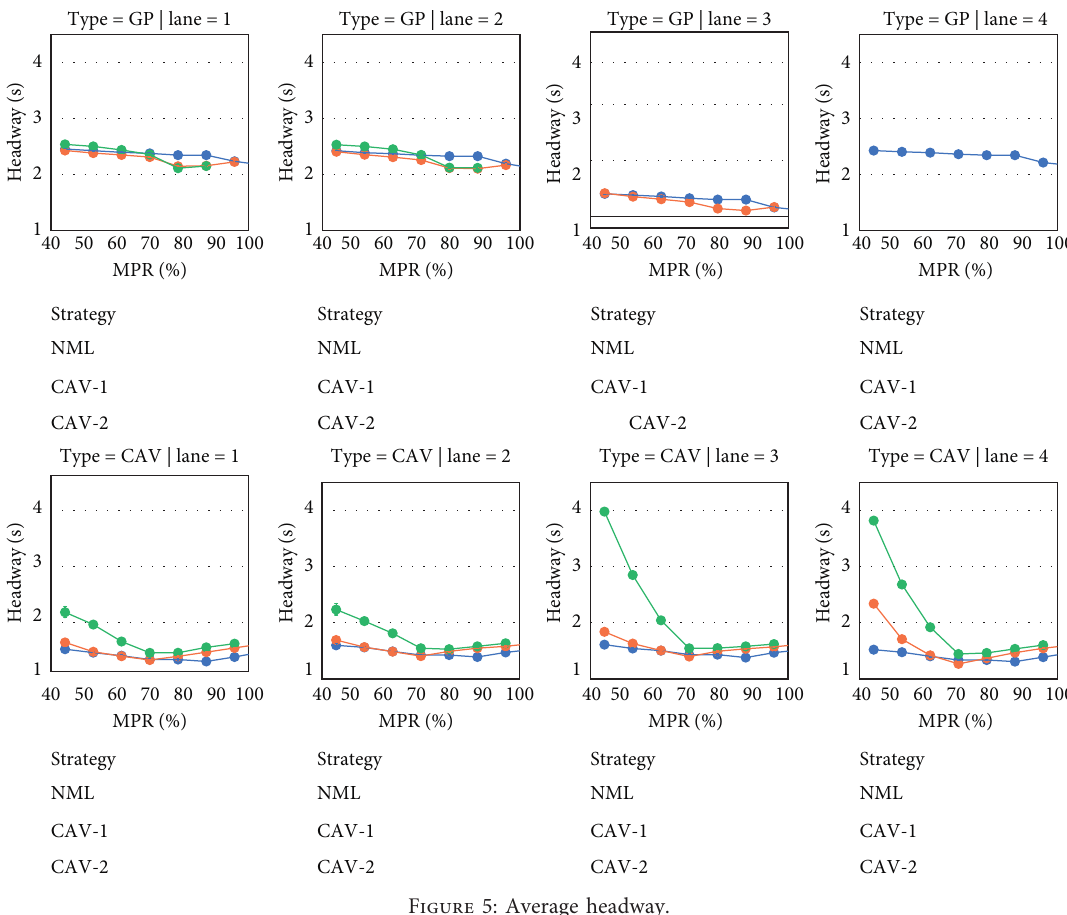
Figure 5: Average